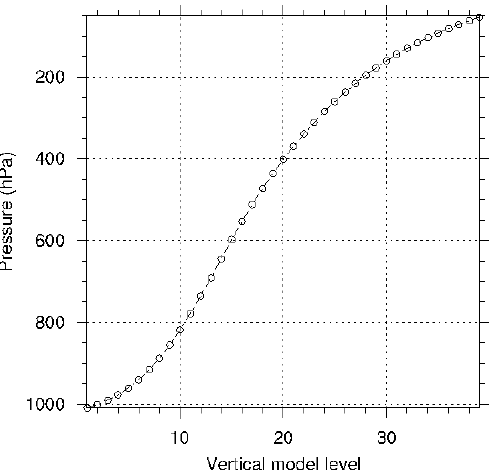
Figure 3. Plot of pressure (hPa) against vertical model levels (WRF, resolution